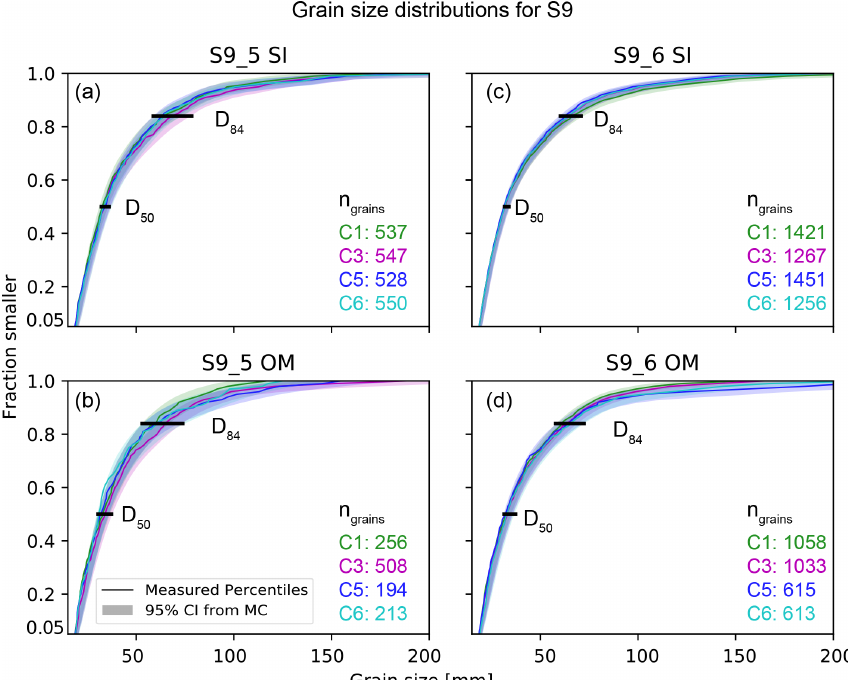
Figure 6. Grain size distributions and percentile uncertainty (modeled 95% confidence interval; CI) for the Entle surveys (S9) for different UAV imagery (SI: single image; OM: orthophoto mosaic; see Fig. 2 for model characteristics and color legend). All data refer to region A (see Fig. 1 for location). D 50 , D 84 : percentiles 50 and 84, respectively; n grains : number of segmented grains. Please note that S9_5 (a, b)